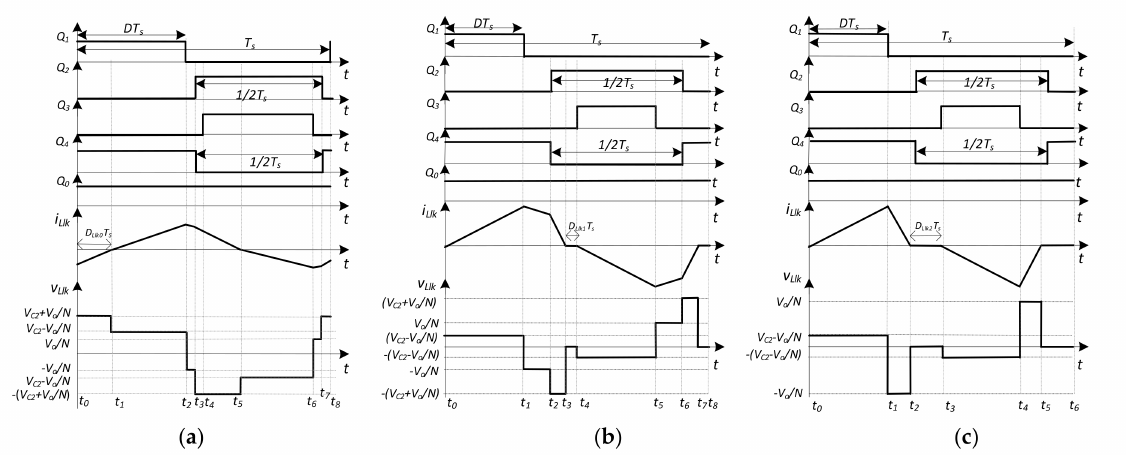
Figure 6. Switching sequence diagram of step-up mode. ( a ) Step-down-CCM; ( b ) Step-down-DCM1; ( c ) Step-down-DCM2.